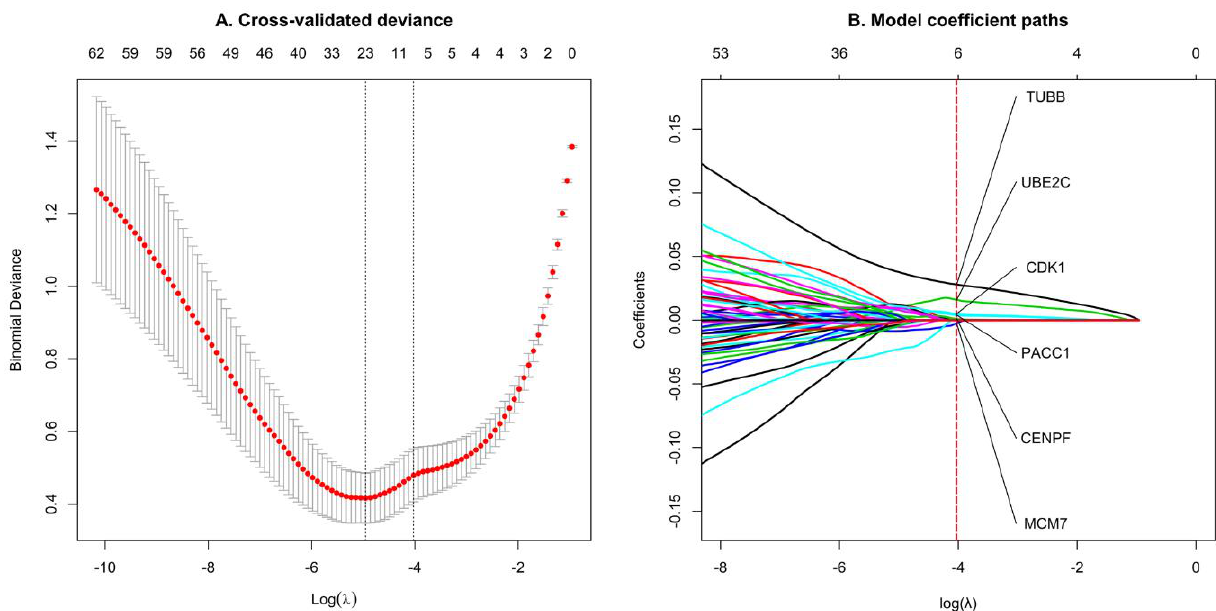
Figure 9. Feature selection was using the LASSO regression model through 10-fold cross-validation and lambda 1se. ( A ) Generate coefficient distribution plots for log(lambda) sequence. ( B ) LASSO non-zero coefficient 6 significant genes in TNBC.